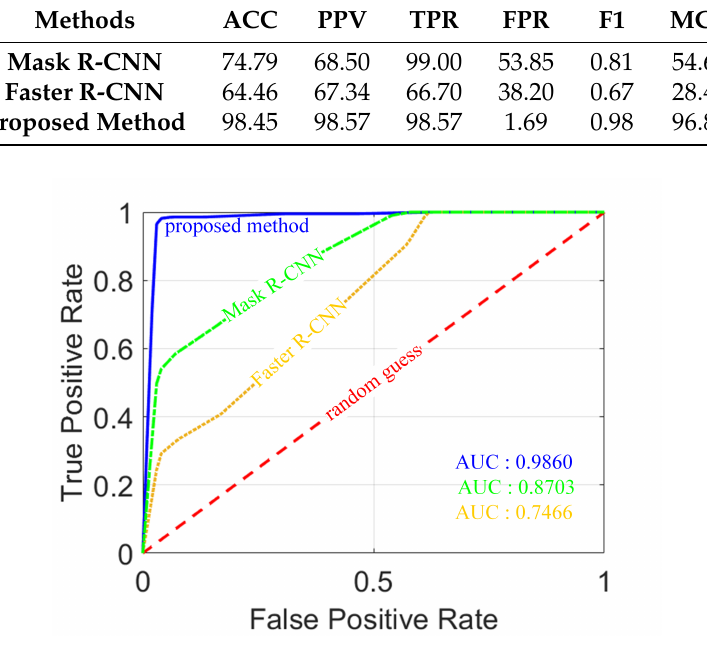
Figure 11. Receiver Operating Characteristic (ROC) curves of three